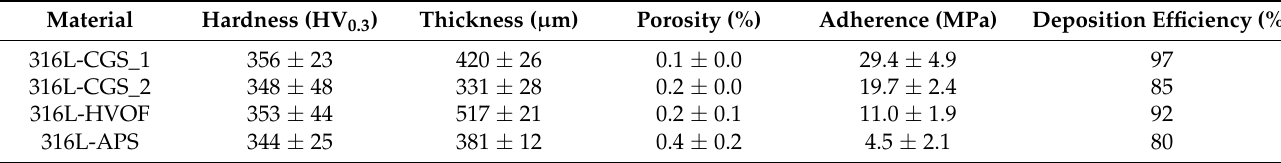
Table 4. Properties of the 316L